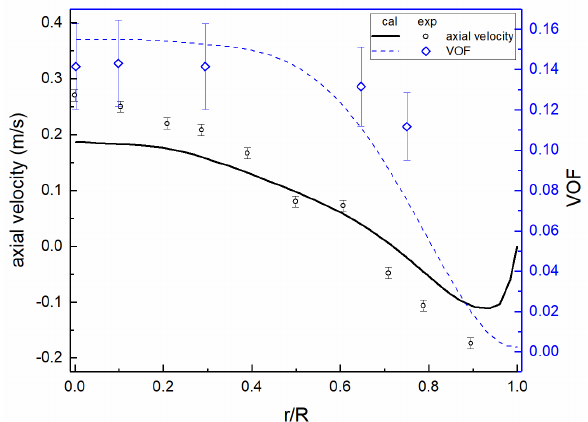
Figure 1. Comparison for the axial velocity and VOF.